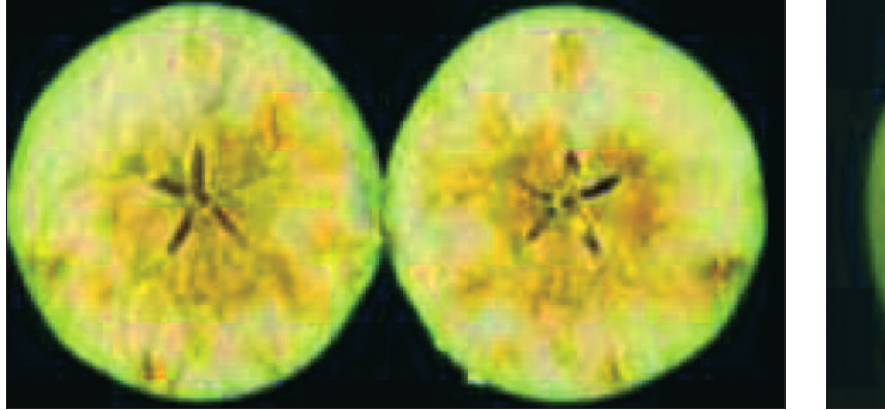
Table 1: Comparing fruit symptoms of Boron and Calcium deficiency